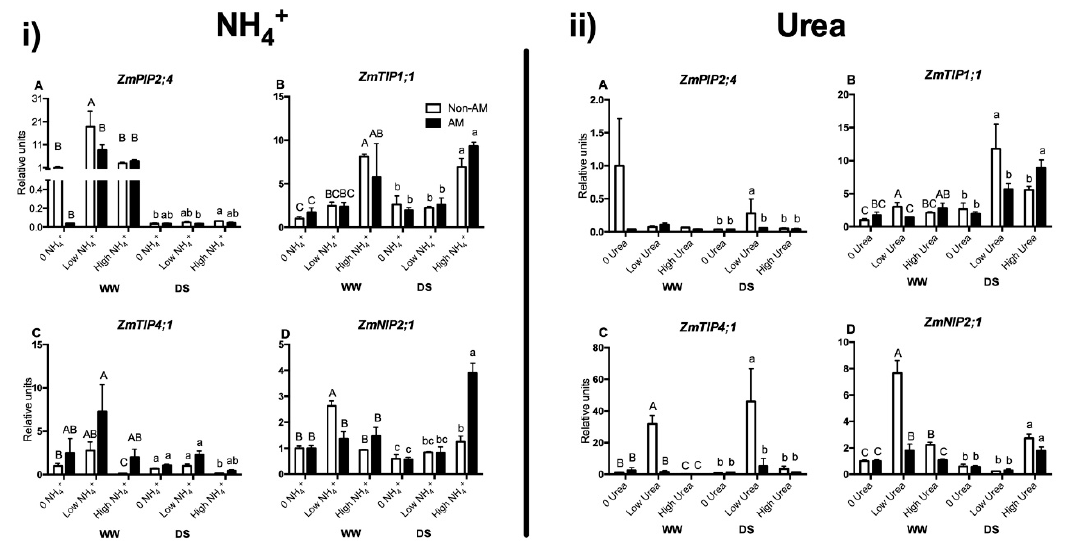
Figure 5. Relative root expression levels for ZmPIP2;4 (( i ) A ) for NH 4 + experiment and (( ii ) A ) for the urea experiment) , ZmTIP1;1 (( i ) B ) for NH 4 + experiment and (( ii ) B ) for the urea experiment) , ZmTIP4;1 (( i ) C ) for NH 4 + experiment and (( ii ) C ) for the urea experiment) and ZmNIP2;2 (( i ) D ) for NH 4 + experiment and (( ii ) D ) for the urea experiment) genes. Maize plants were inoculated or not with the AM fungus Rhizophagus irregularis (AM), submitted to two water regimes (well-watered, WW or drought stress, DS for 14 days) and grown under di ff erent ammonium or urea concentrations (0 N added; low N, 3 µ M or high N, 10 mM). Data represents the means of three biological replicates ± SE. Di ff erent letter (uppercase for WW treatments and lowercase for DS treatments) indicates significant di ff erences between treatments ( p < 0.05) based on Duncan’s test.